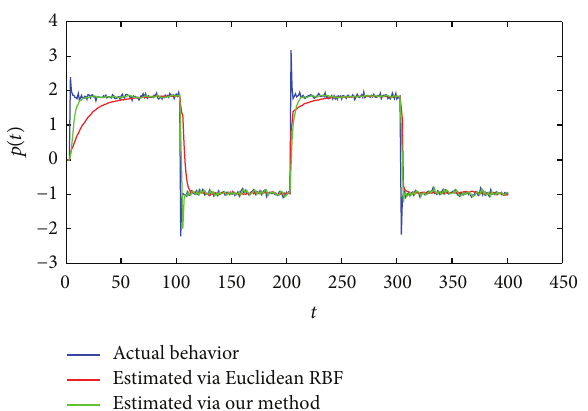
Figure 9: Comparing the actual plant’s output with the two RBF kernels: Euclidean and proposed.